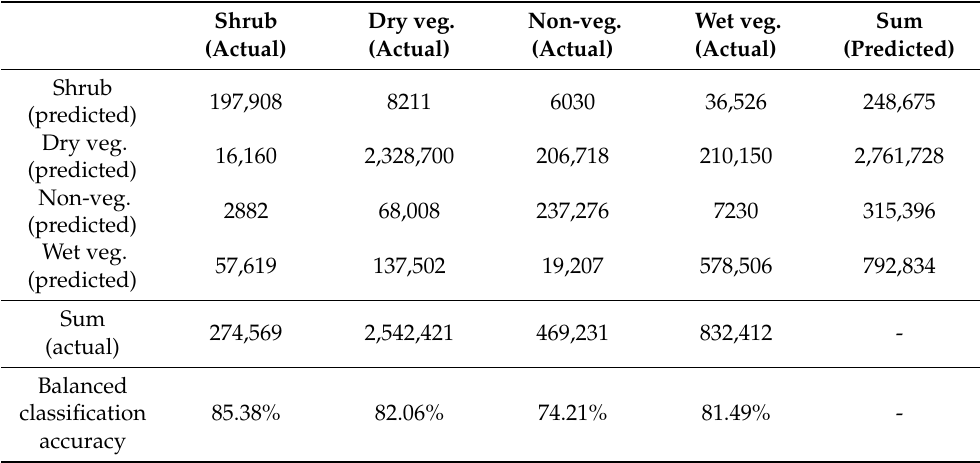
Table 2. Confusion matrix showing the number of actual vs. predicted pixels in each vegetation class for the test-set data. The bolded numbers indicate the number of correctly classified pixels in each class. The bottom row reports the balanced classification accuracy for each land cover